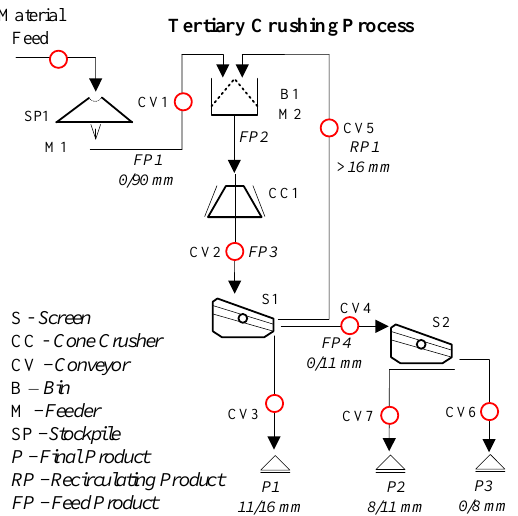
Figure 3. Crushing plant layout for the application of conveyor mass flow calculation. Table 2. Mass measuring units in the crushing plant.